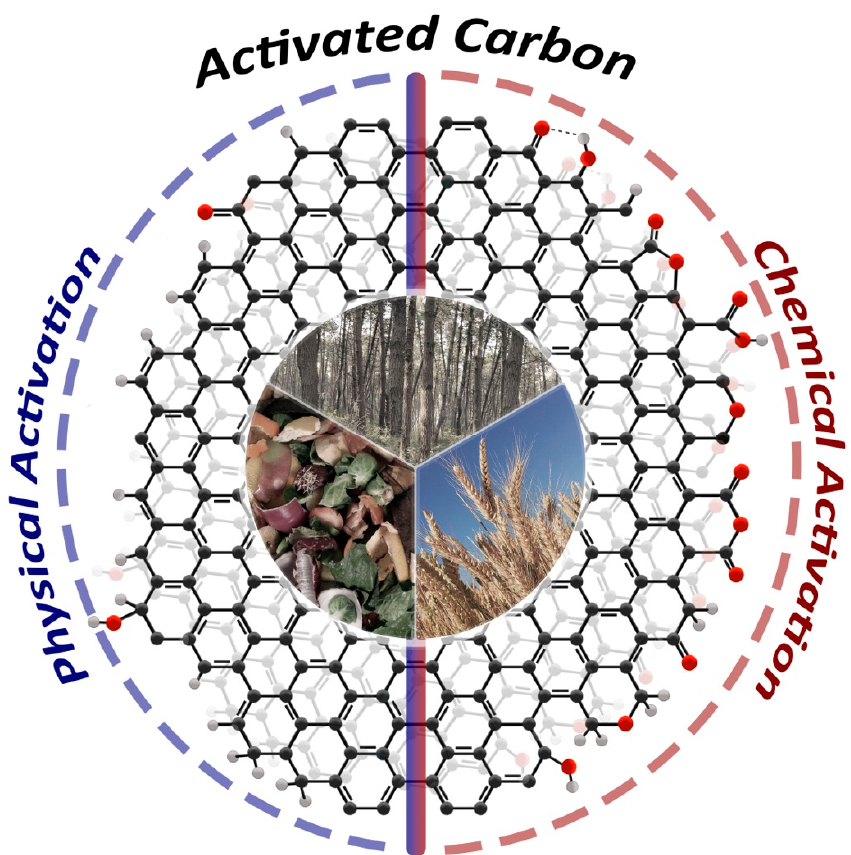
Figure 4. Center: activated carbons principal biomass precursors, namely forest scraps, agricultural discards, and industrial processes wastes (mainly from food and paper industries). External border: schematic representation of graphene-like plains obtained after biomasses pyrolysis; on the left side is depicted the typical average chemical speciation of graphitic domain borders in the case of physical activation (mainly H-terminations with few oxygenated ones); on the right side is reported the typical average chemical speciation of graphitic domain borders in the case of chemical activation (various oxygen-containing functional groups).